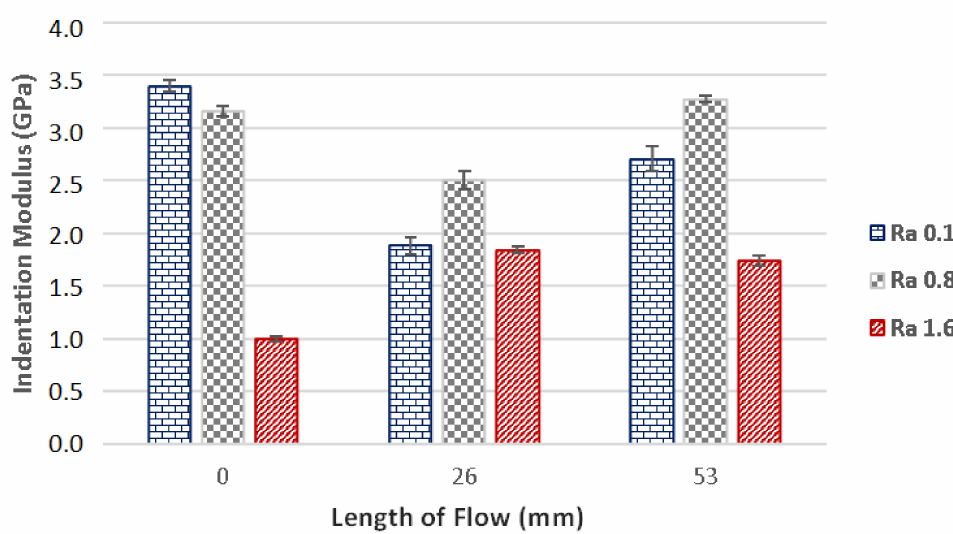
Figure 9. The dependence of the flow length on the indentation modulus for plates with following surface roughness: Ra 0.1, Ra 0.8 and Ra 1.6. The injection pressure was 400